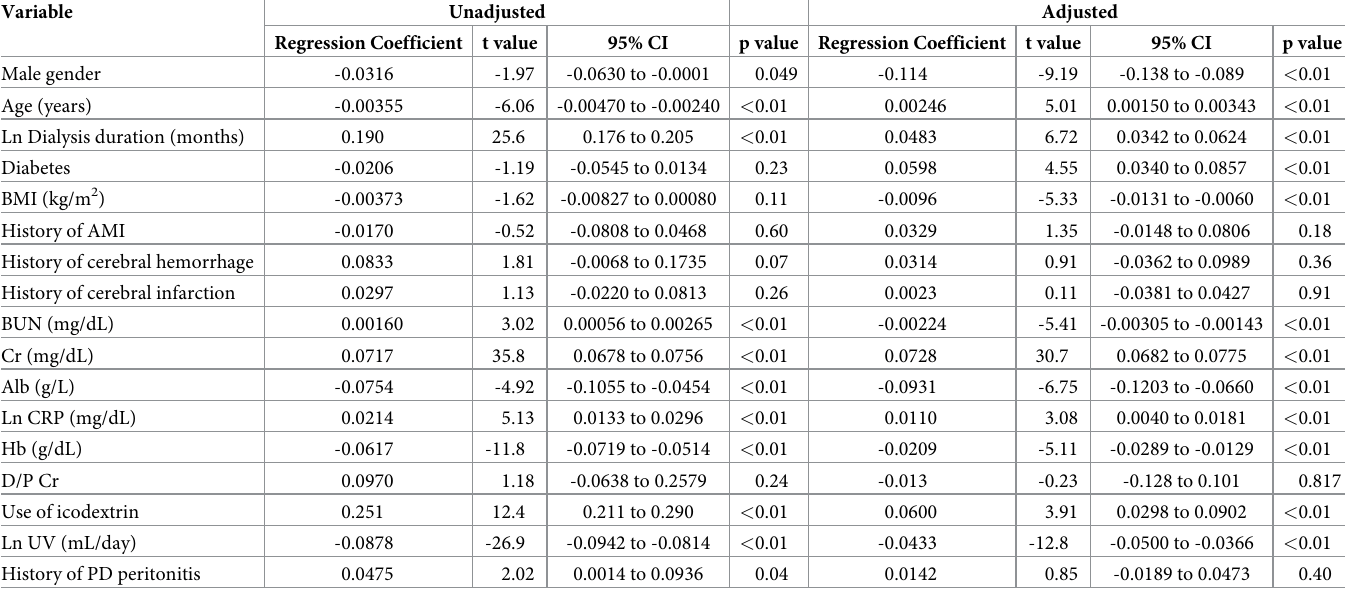
Table 2. Contributing factors for serum